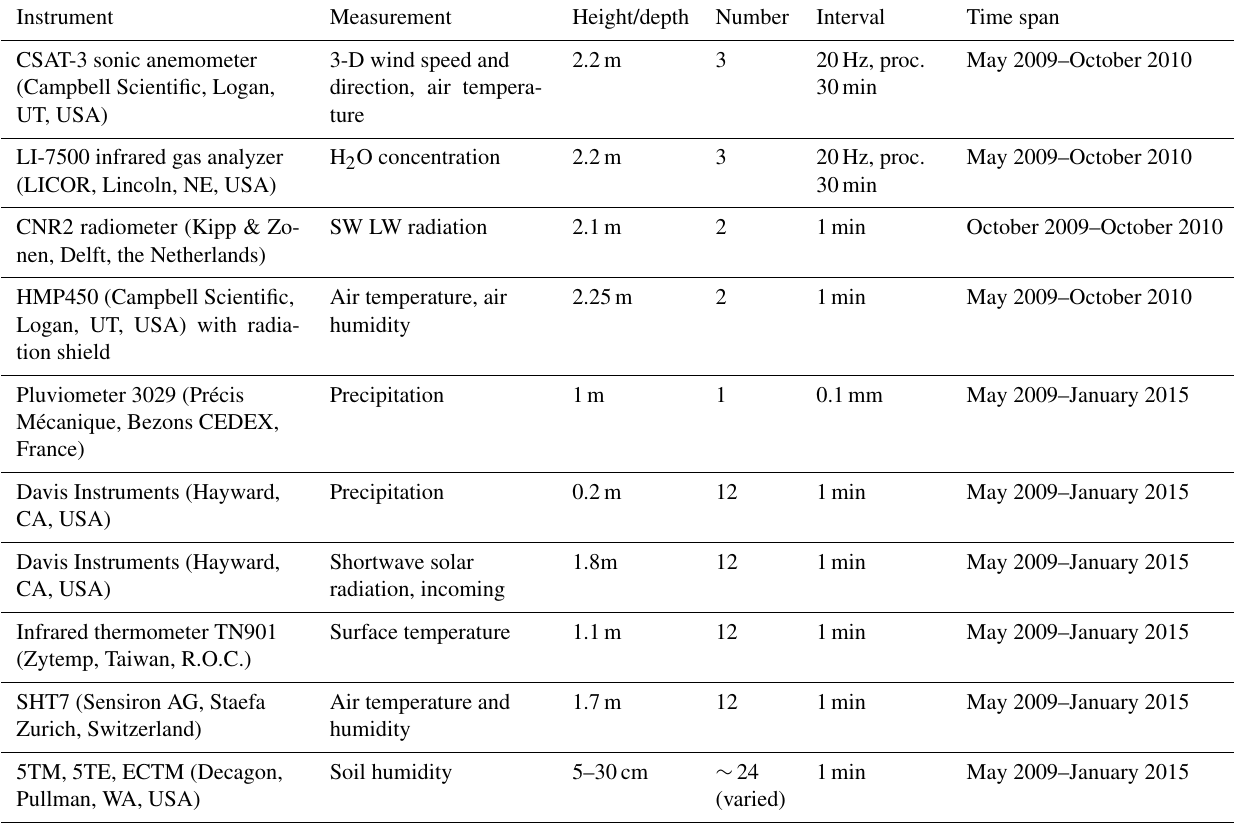
Table 1. Inventory of instruments used for energy balance analysis. The name of the sensor or instrument is followed by the measurement it performs, the height and depth of each sensor, the total number used, and the interval of measurement. The heights were identical at both measurement